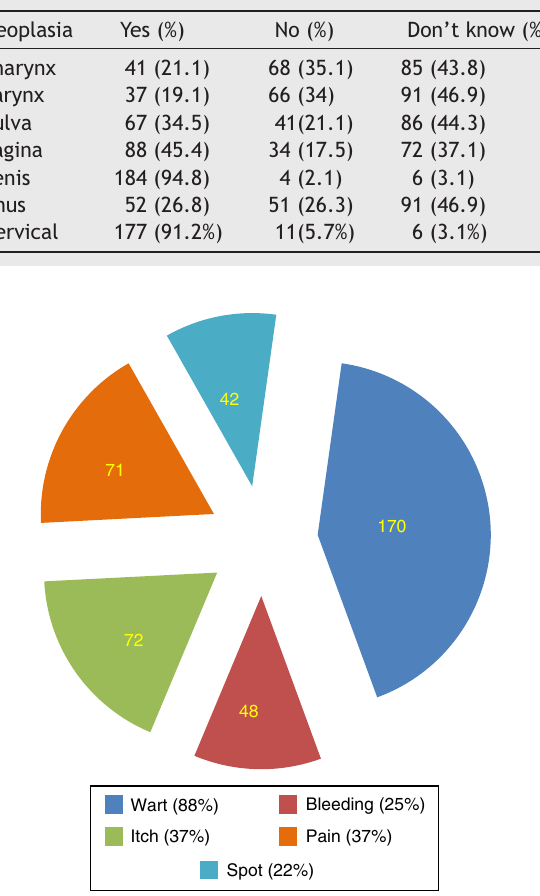
Figure 1 Signs and symptoms of HPV infection in accordance with the understanding of the surveyed